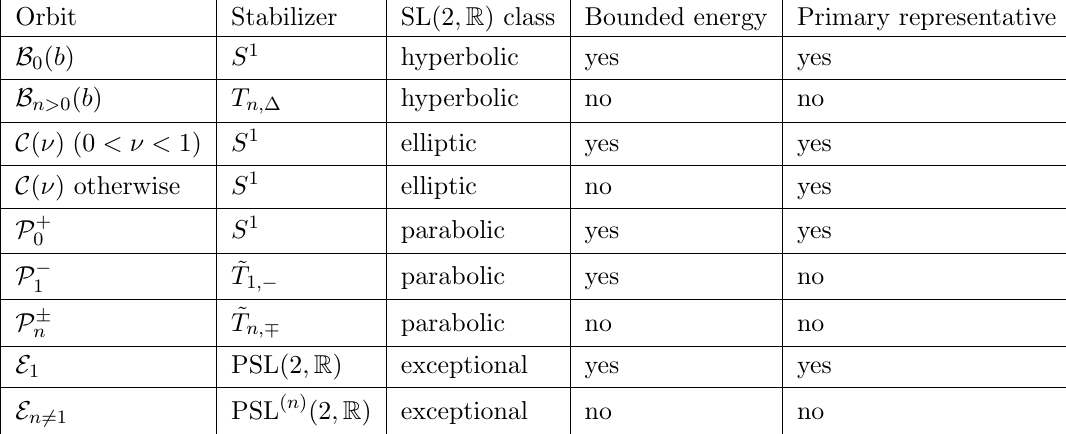
Table 1 . Summarized form of the various features of the Virasoro orbits as classi(cid:12)ed in [5] and reviewed in appendix